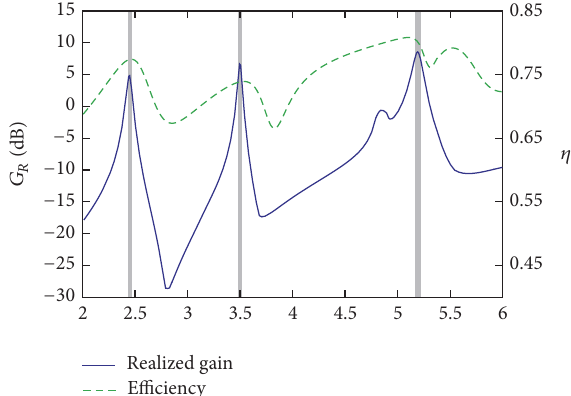
Figure 4: Realized gain and radiation efficiency of the designed antenna shown in Figure